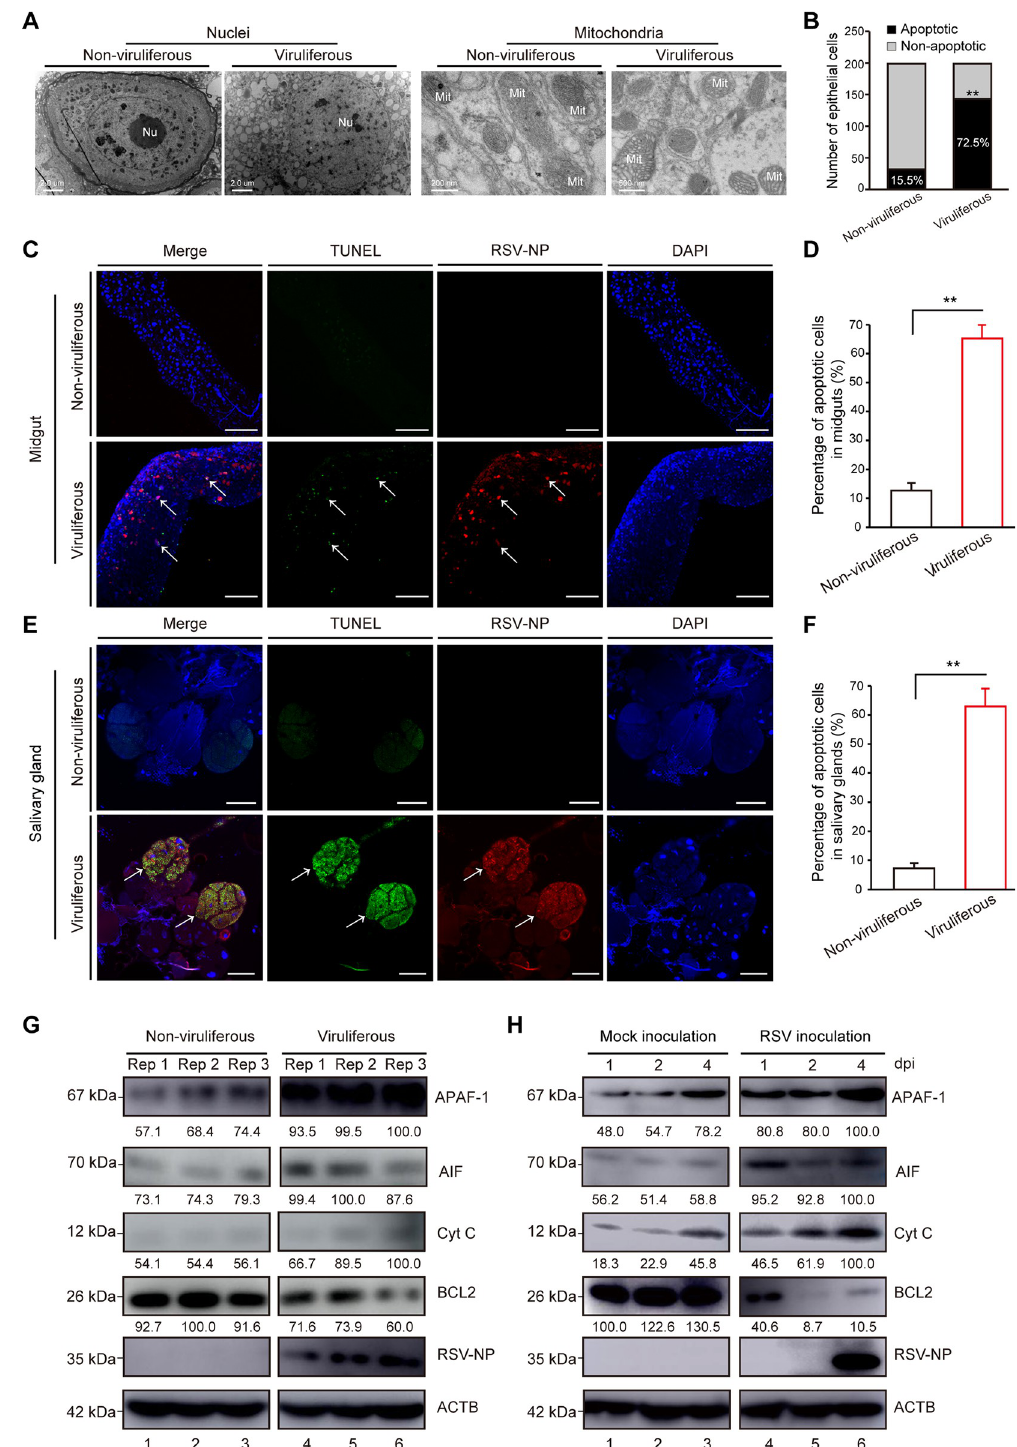
Fig 1. Viral infection induces apoptosis in insect vectors. (A) The nuclei and mitochondria of midgut epithelial cells from nonviruliferous and viruliferous SBPHs were detected using TEM. Nu, nucleus. Mit, mitochondrion. (B) Biological statistics of apoptotic cells from nonviruliferous and viruliferous SBPHs. �� , p < 0.01 by the student t-test. (C–F) TUNEL assay showing midgut cells (C) and salivary gland cells (E) of nonviruliferous and viruliferous SBPHs. Apoptosis cells were labeled with TUNEL (green), RSV-NP (red) and DAPI straining (blue). Bar, 100 μ m. Biological statistics of apoptotic cells from